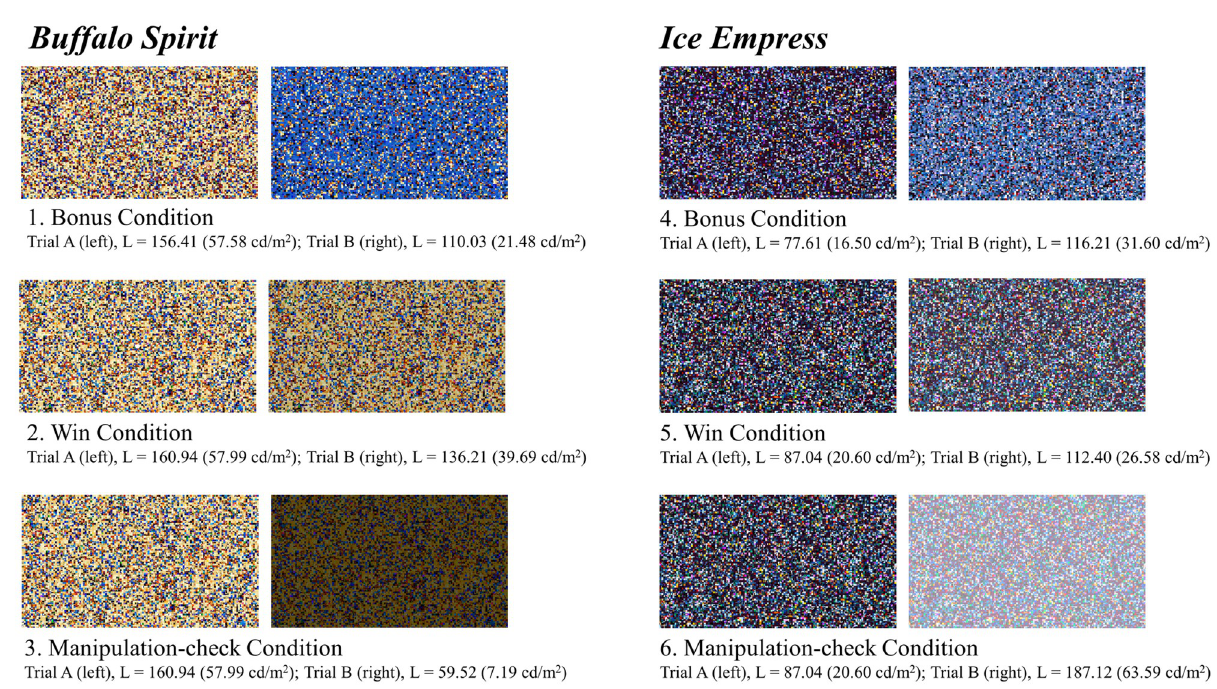
Fig 6. Scrambled images of slot machine outcomes. L = objective luminance, cd/m2 = photometer measured brightness rating in situ ambient lighting.